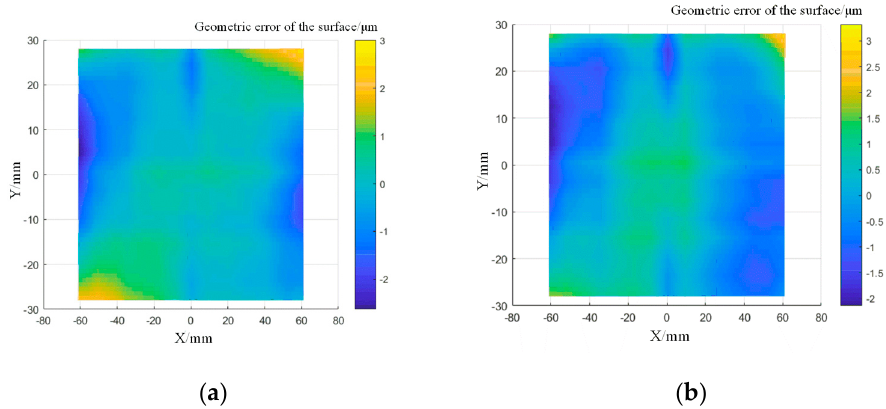
Figure 13. Distribution of the surface profile errors of the sample after compensation: ( a ) surface profile error distribution after five times of polishing; ( b ) surface profile error distribution after ten times of polishing.